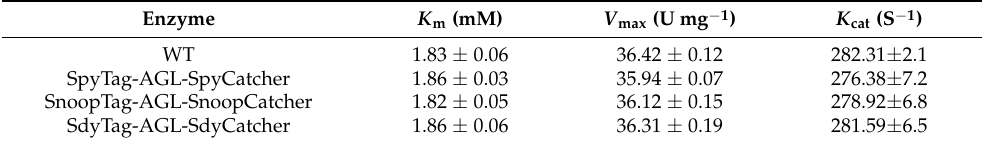
Table 2. Kinetic parameters of wild-type AGL and cyclized